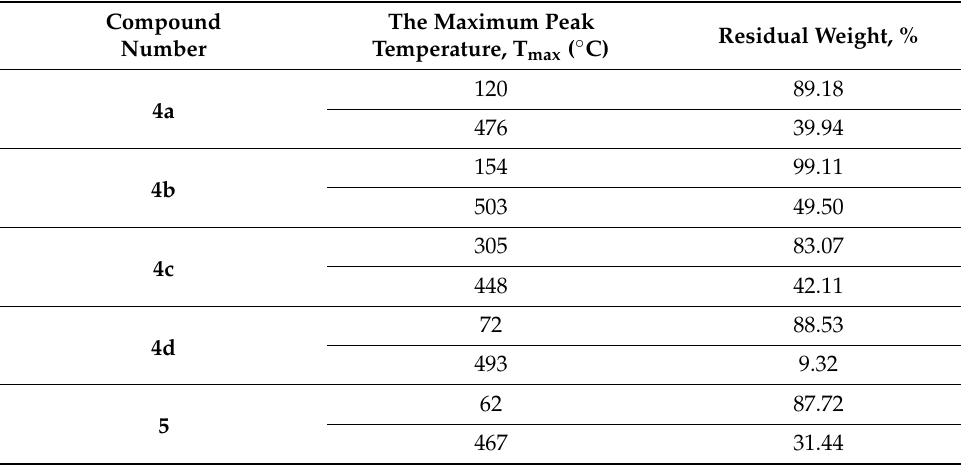
Table 4. TGA/DTG parameters of synthesized phenolic